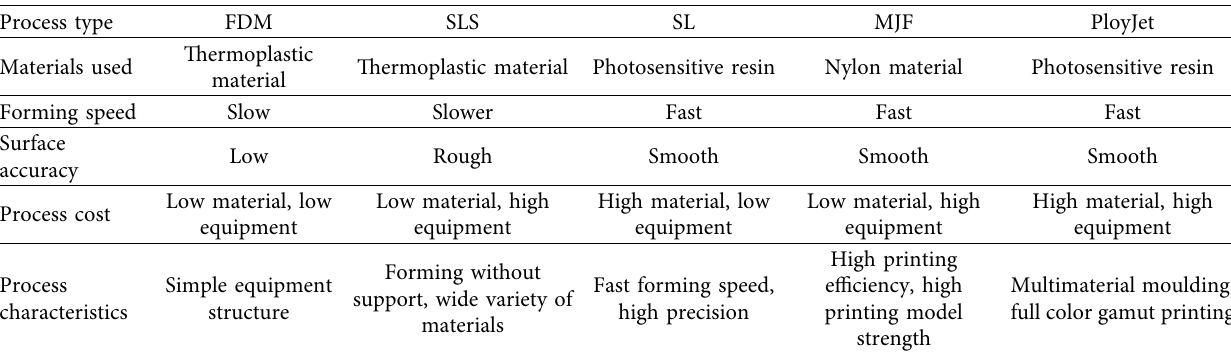
Table 4: Comparison of various 3D printing